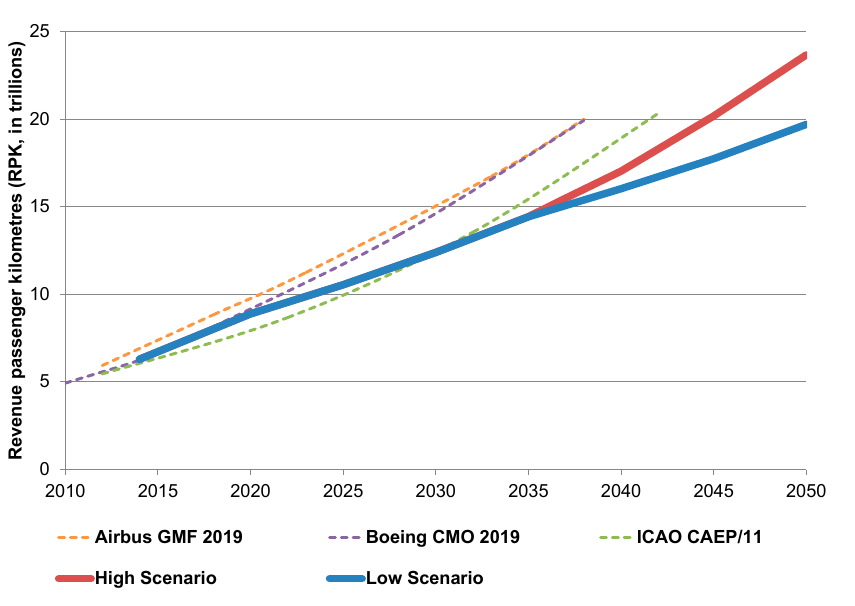
Figure 14. Fleet forecast results in the Low Scenario.